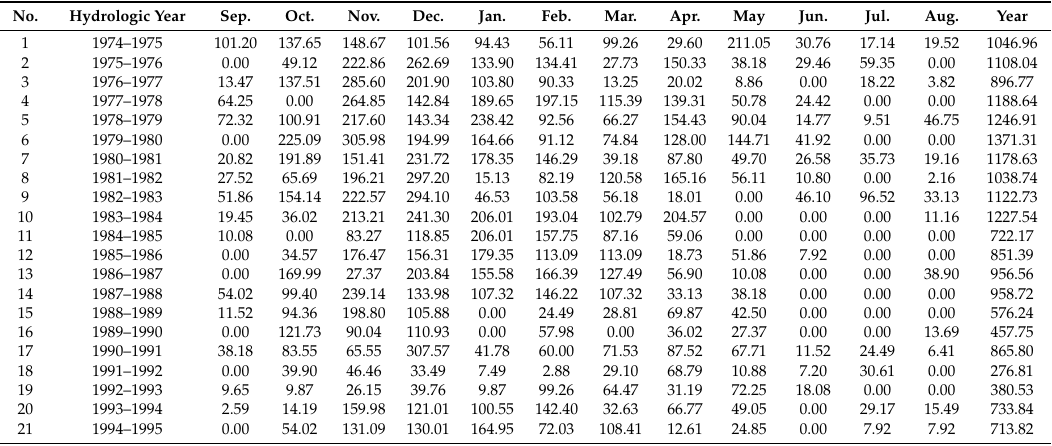
Table A1. Monthly and yearly precipitation heights (mm).